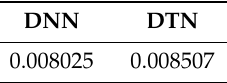
Table 14. The runtime of online diagnosis models without and with transfer learning. (unit: